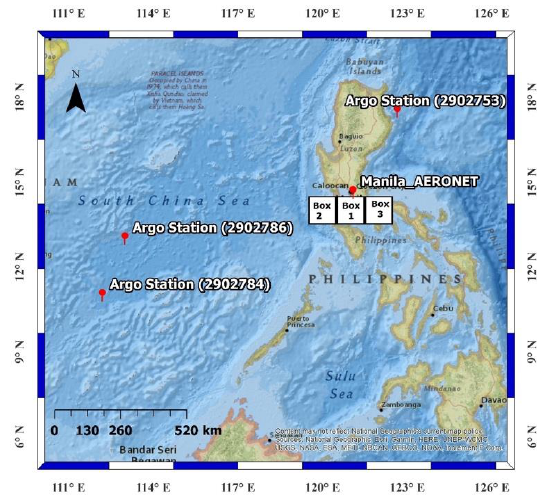
Figure 3. Locations of various Argo stations and the Manila AERONET station along with three boxes chosen for the analysis of various parameters using satellite data. (Bathymetry base map source: National Geographic).